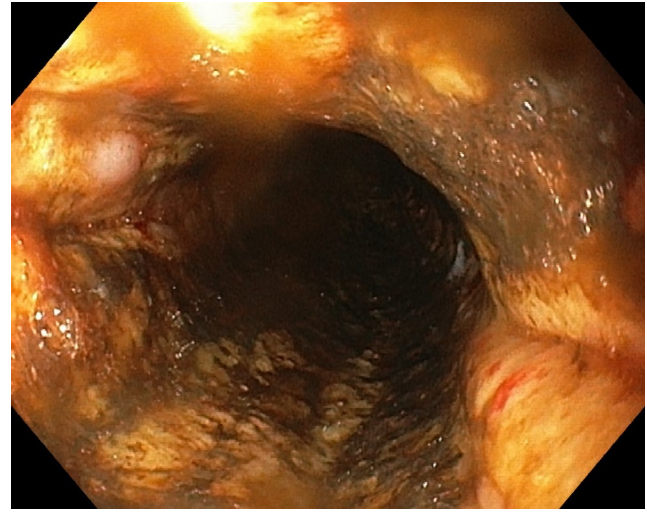
Figure 3. Circumferential blackening of the esophageal mucosa.